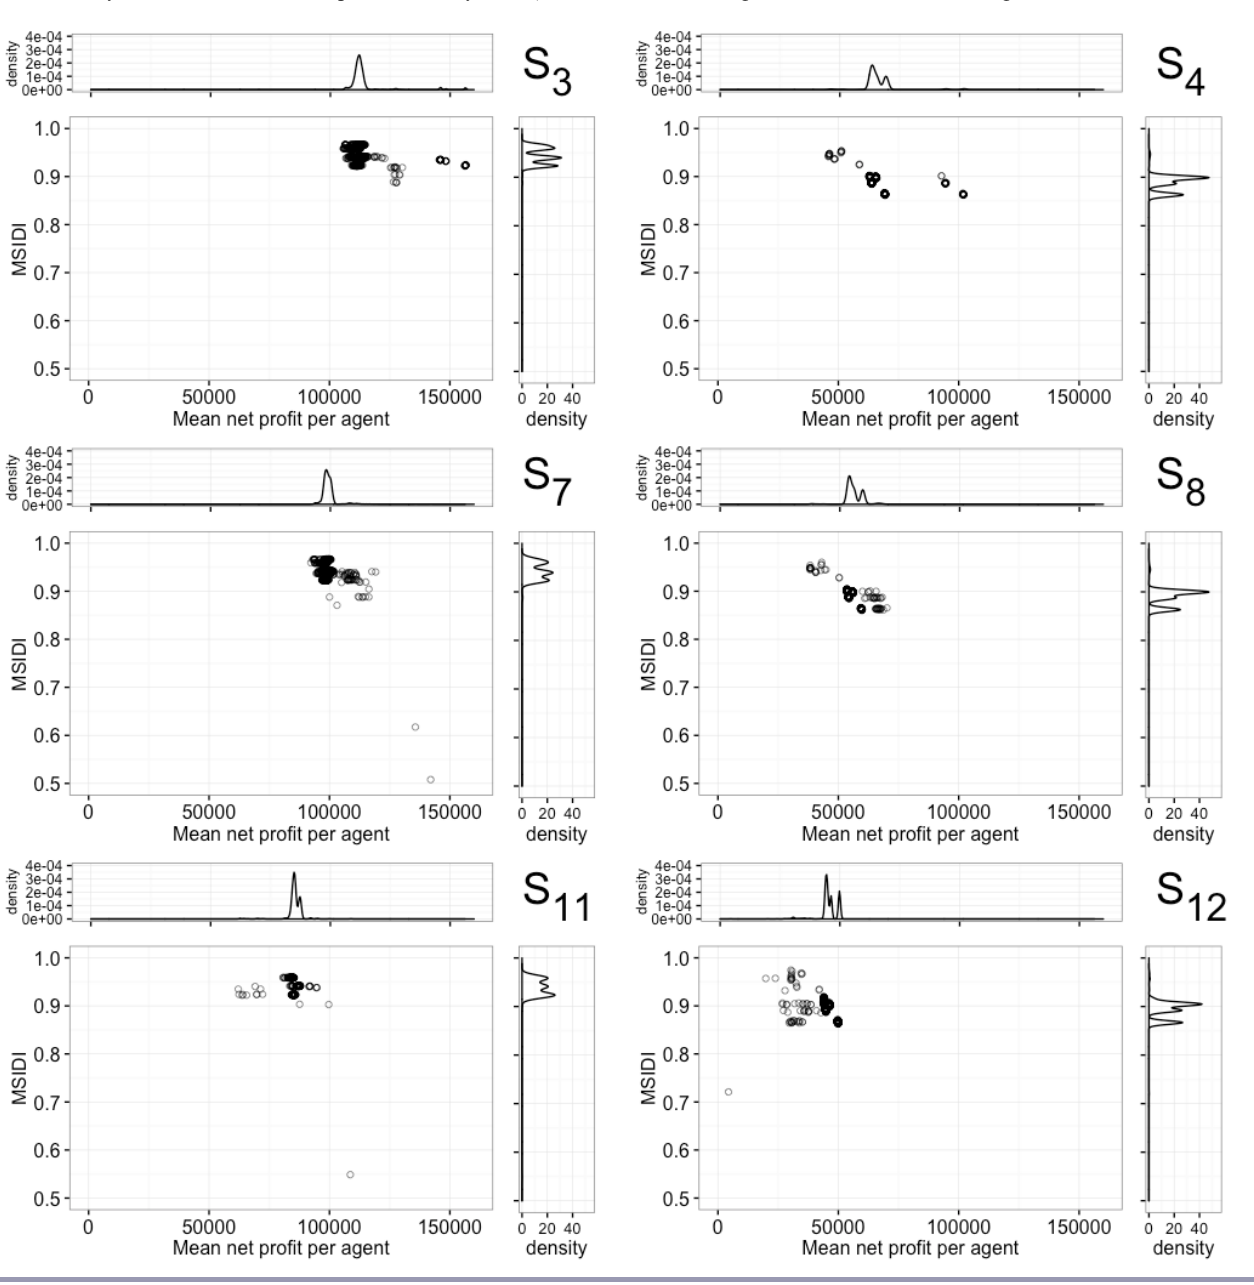
Fig. 7 . Stability landscapes for scenarios that introduce an artificial market for switchgrass. The baseline perturbation regime is on the left; the alternative is on the right. Coping capacity diminishes from the top row to the bottom. Landscape configuration (as measured by MSIDI: Modified Simpson Diversity Index) remains stable, though less so than as seen in Fig.